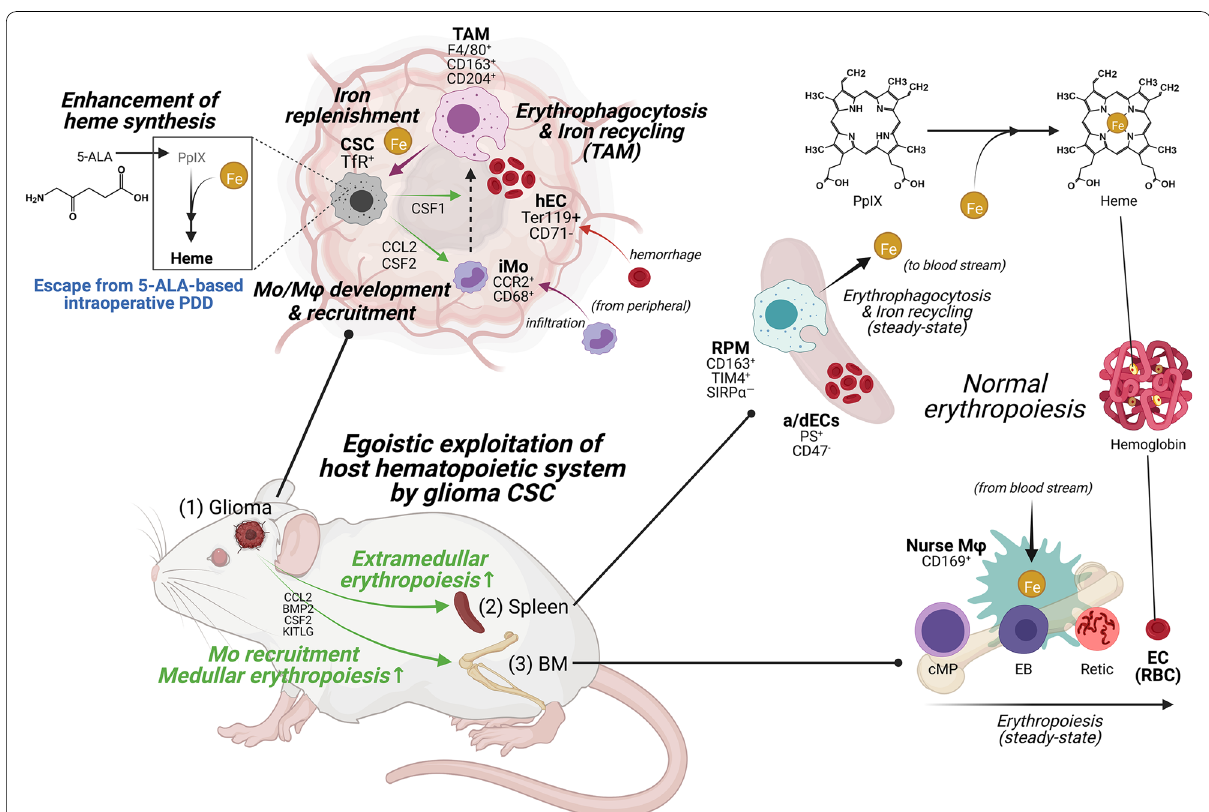
Fig. 1 Systemic cancer ecosystem self-organized by CSCs in glioma-bearing mice. A functional niche network for CSCs to replenish iron, indispensable to GSC expansion themselves, is delineated by interconnecting GSC-induced TAM development in brain, and GSC-triggered enhanced erythropoiesis in peripheral. (1) Glioma: TfR + GSCs recruit CCR2 + CD68 + inflammatory monocytes (iMo) from peripheral BM and induce F4/80 + CD163 + CD204 + tumor-associated macrophages (TAMs) through secreting some soluble factors such as CCL2 and CSF1/2 [Mo/ Mφ development]. On the other hand, GSCs facilitate medullar and extramedullar erythropoiesis in peripheral hematopoietic organs, i.e., BM and spleen, potentially through secreting some soluble mediators. Collectively, Ter119 + hemorrhaged erythrocytes (hEC) infiltrating from peripheral are phagocytosed by the TAMs in brain and catabolized into iron [erythrophagocytosis and iron recycling]. Iron is stored in TAMs and potentially released upon the demands of GSCs highly expressing the receptor for the iron-carrier transferrin (Tf) [iron replenishment]. (2) Spleen: CD163 + TIM4 + red pulp macrophages (RPMs) originally have the ability to engulf the aged and damaged erythrocytes (a/dECs) externalizing phosphatidylserine (PS) at the cell surface to recycle and release iron into blood stream at the time of needs [erythrophagocytosis and iron recycling]. (3) Bone marrow (BM): hematopoietic differentiation from common myeloid progenitors (cMP) to erythroblasts (EB), reticulocytes (Retic), and erythrocytes (EC) is enhanced in glioma-bearing mouse BM [erythropoiesis], potentially maintaining the influx of erythrocytes hemorrhaged into glioma tissues. In BM erythropoiesis, CD169 + nurse macrophages uptake the recycling iron from blood stream and supply it for EBs to synthesize hemoglobin from heme composed of protoporphyrin IX (PpIX) and iron. Such heme synthesis pathway is also elevated in iron-demanding TfR + GSCs, causing them to escape from 5-ALA-based photodynamic diagnosis (PDD) during surgical